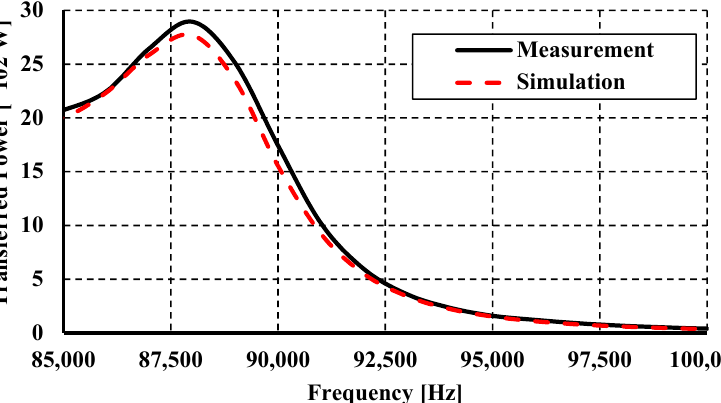
Figure 7. Model verification—Transferred power dependency on frequency (Non-shielded system).